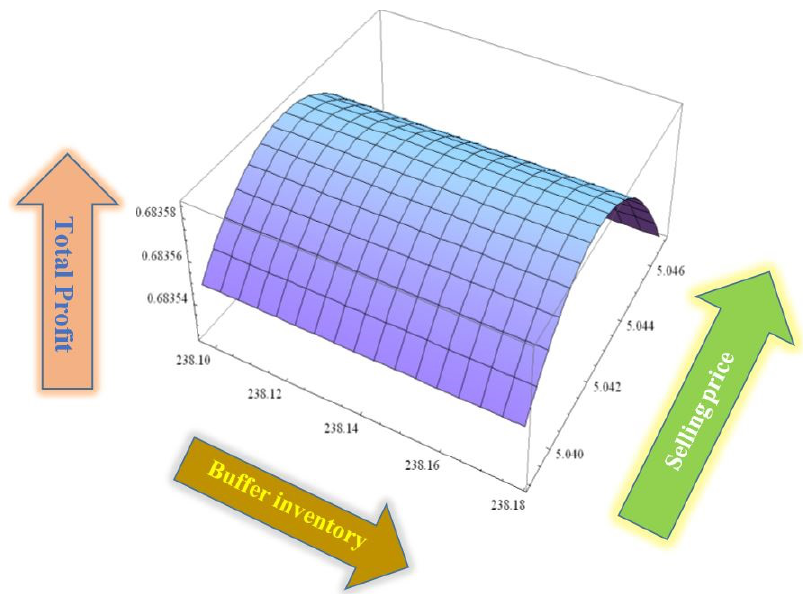
Figure 1. Graphical representation of total profit with respect to buffer inventory and selling price.